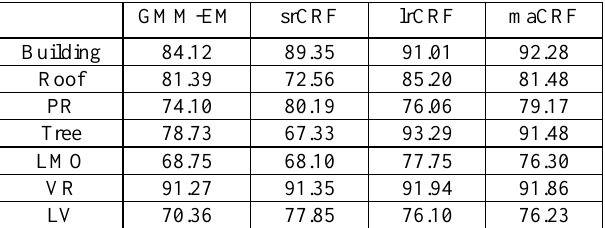
Table 3. Precision of each class in four methods.